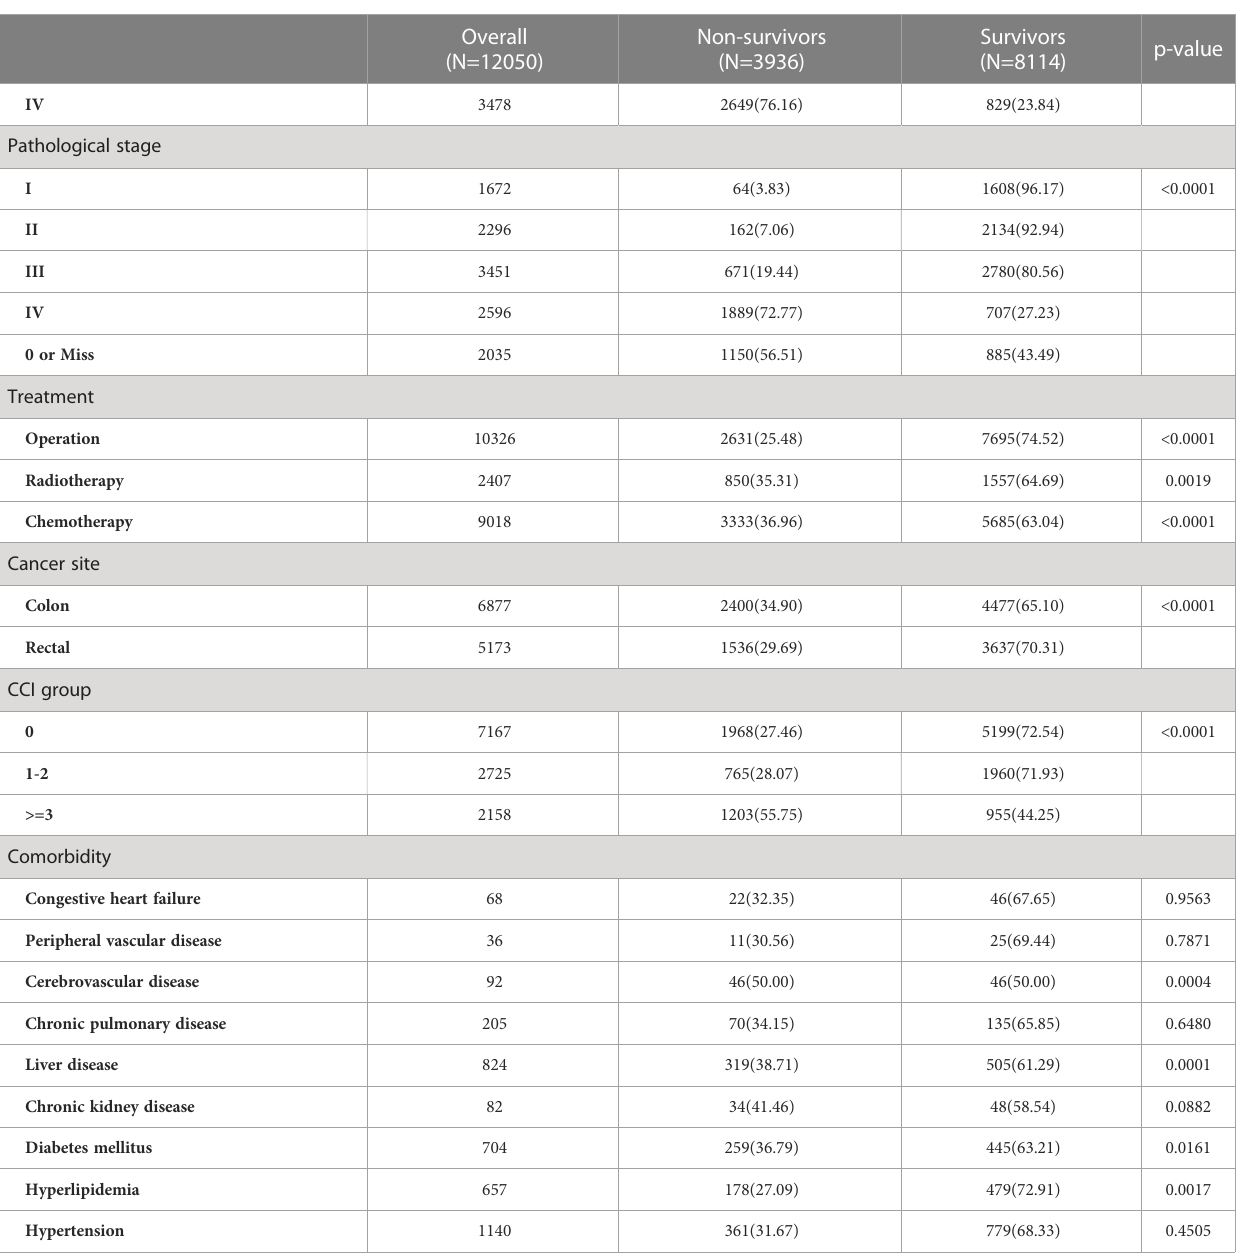
1.02-4.76; p=0.0451). Patients with hyperlipidemia and early clinical stage EO-CRC had a lower mortality risk than those Patients with cerebrovascular disease and early clinical stage EO- CRC had a higher cancer-speci fi c mortality risk than those without the cerebrovascular disease (HR: 3.30; 95% CI: 1.50-7.27; p=0.0031). Patients with chronic kidney disease and late clinical-stage EO-CRC had a lower risk of mortality than those without chronic kidney disease (HR: 0.54; 95% CI: 0.32-0.92; p=0.0226). Among patients undergoing radiotherapy, those with cerebrovascular disease had a higher cancer-speci fi c mortality risk than those without